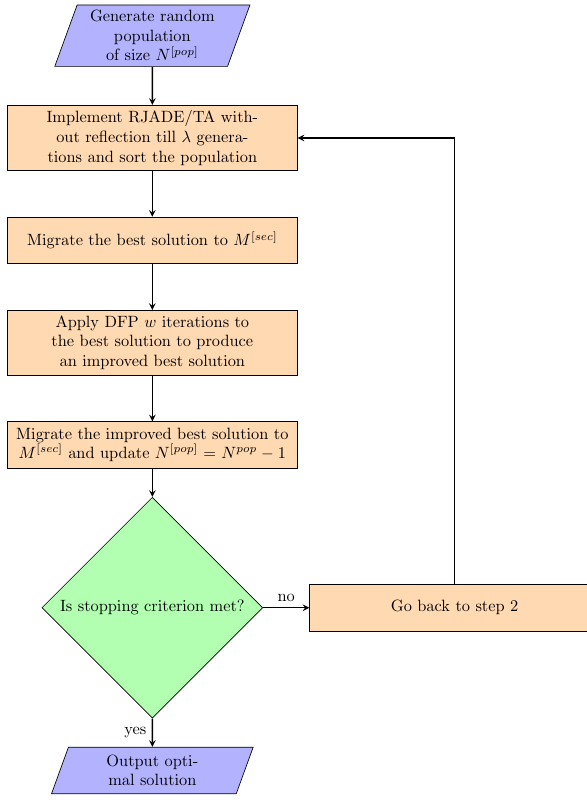
Figure 1. Flowchart of